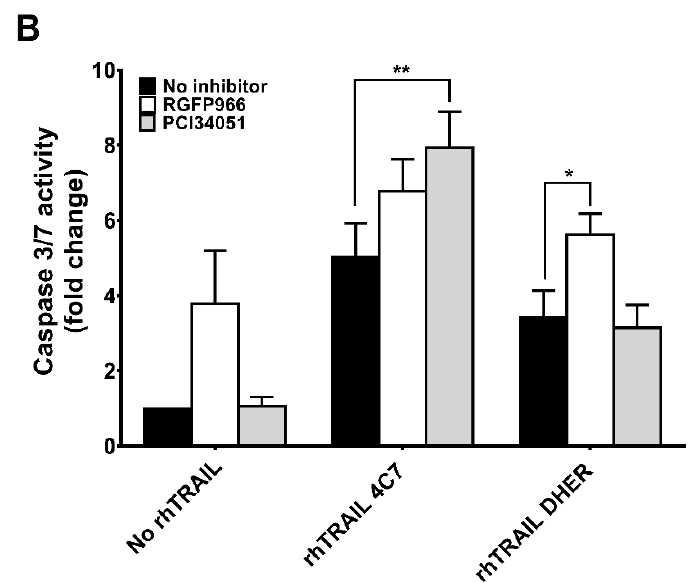
Figure 4. RGFP966 or PCI34051 enhances TRAIL sensitivity on 3D spheroid model. ( A ) 3D spheroids were constructed on DLD-1 or WiDr cells after 72 h culturing in ultra-low attachment round bottom plates. Morphology changes were observed under an inverted light microscope with 40 × magnification. ( B ) The DLD-1 spheroids were generated and transferred to a 96-well white wall plate and caspase3 / 7 activity was detected after adding 5 ng / mL rhTRAIL 4C7 or DHER overnight. Luminescence were measured after 2 h incubation with caspase 3 / 7 reagent. p values were analyzed by one-way ANOVA in Turkey’s multiple comparison with Graphpad Prism version 7.0. * 0.01 ≤ p ≤ 0.05, ** 0.001 ≤ p ≤ 0.01.